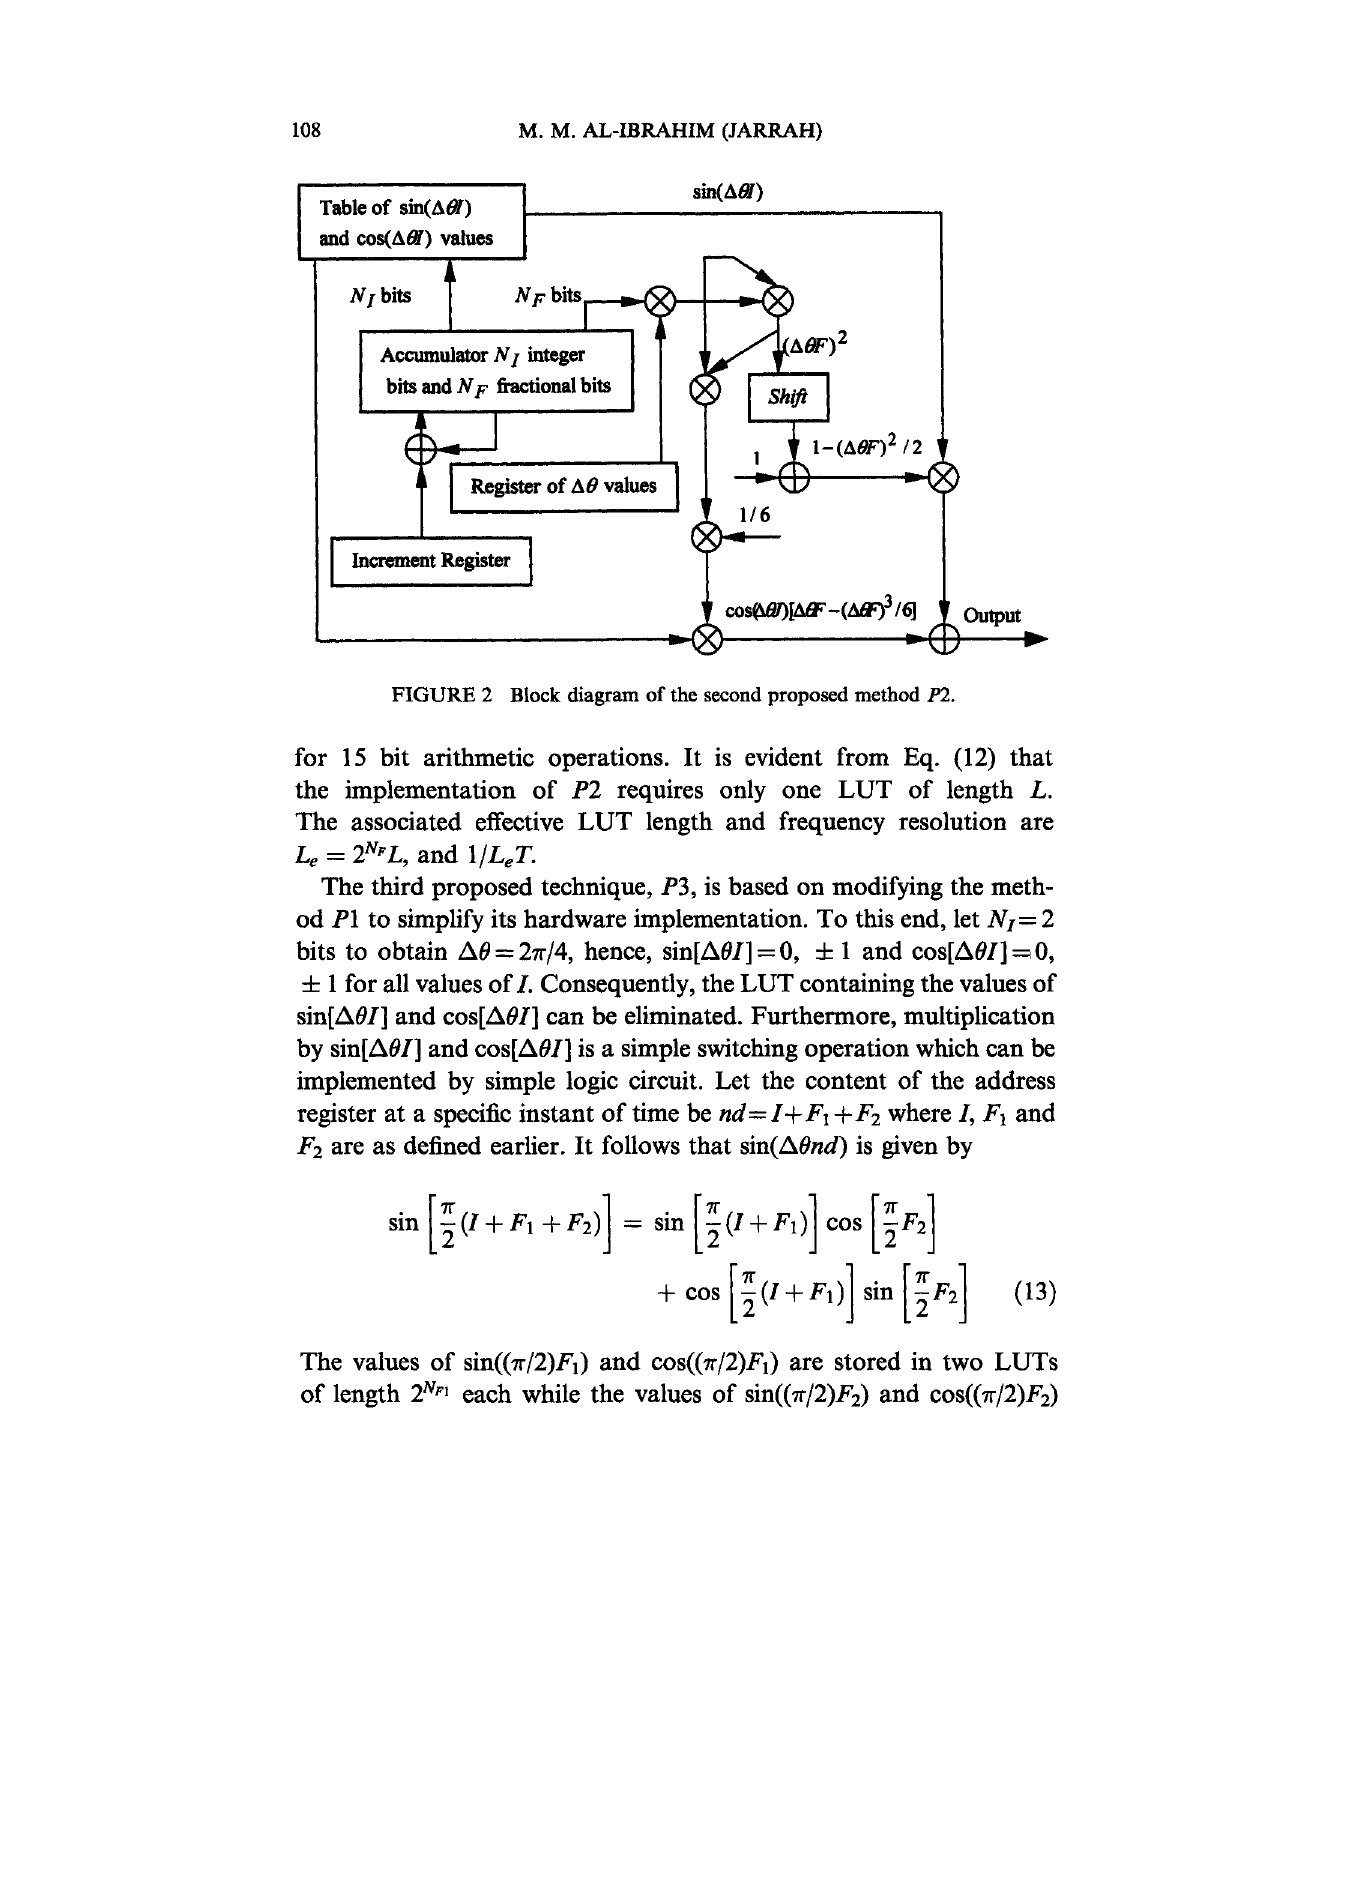
FIGURE 2 Block diagram of the second proposed method